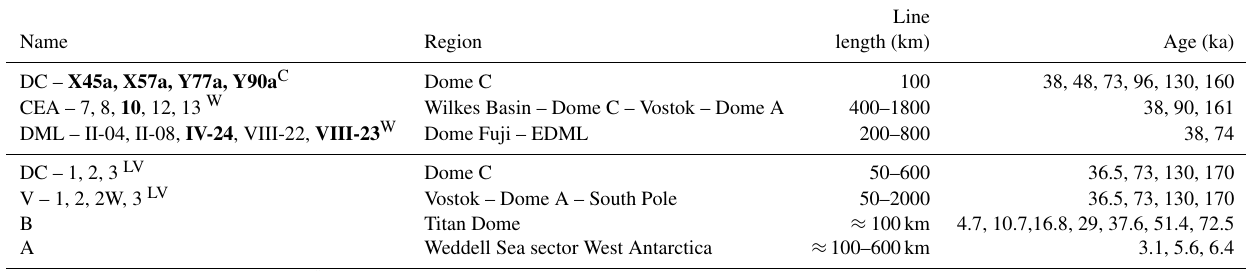
Table 1. Overview of analysed isochrones. Transects presented in this work are DC–X45a, X57a, Y77a, Y90a, CEA-10 and DML VIII- 23/IV-24 (in